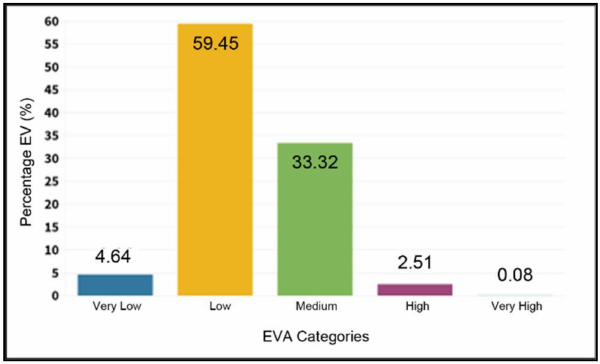
Figure 6. Percentage of each EVA zone in the Punjab